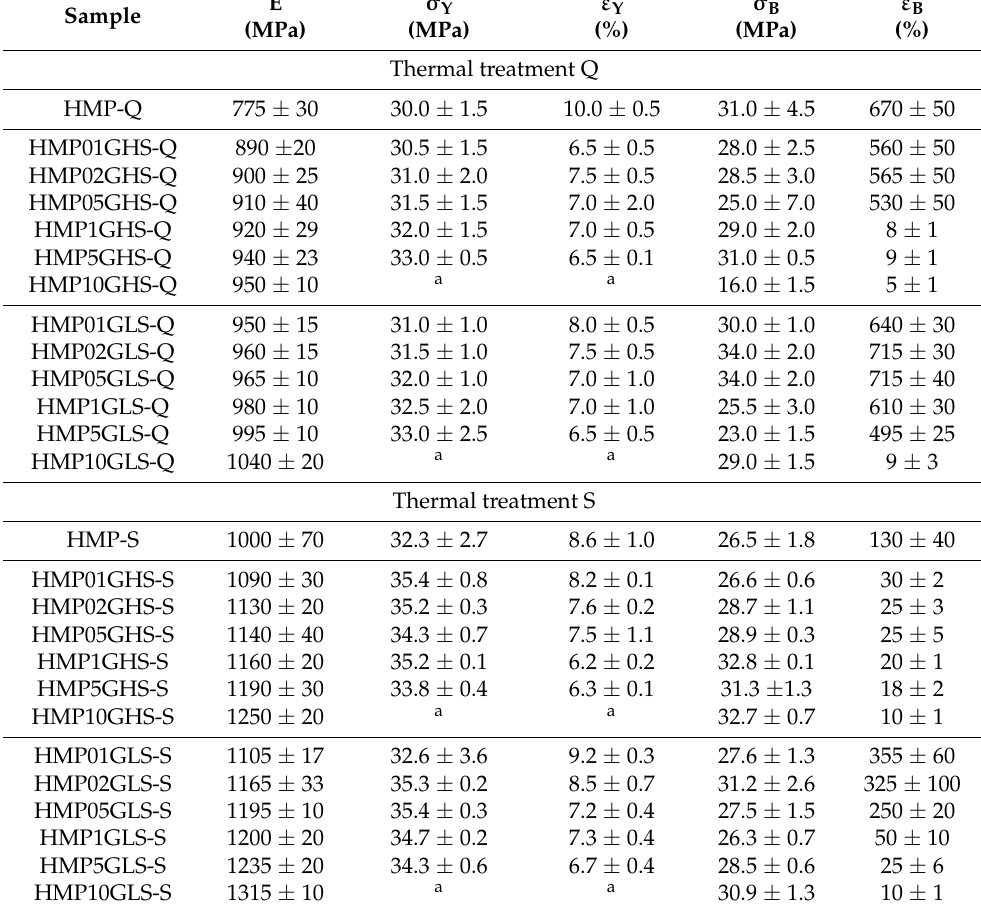
Table 3. Mechanical parameters for all of the GHS and GLS nanocomposites at the two thermal treatments: Young’s modulus ( E ); yield stress ( σ Y ), yield strain ( ε Y ); tensile strength ( σ B ), strain at break ( ε B